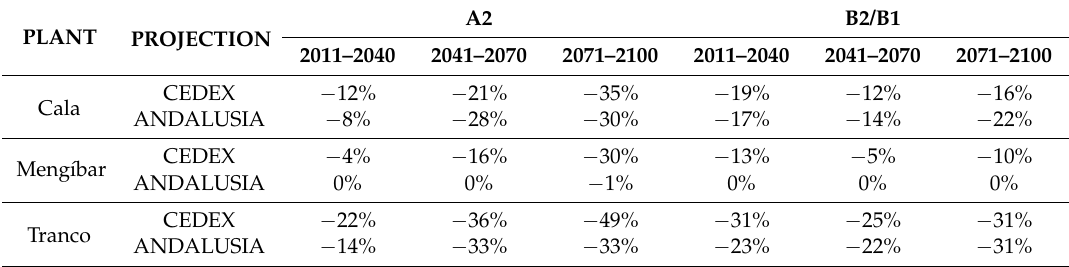
Table 4. Projected reductions in production (%). CEDEX vs. Regional Government of Andalusia.